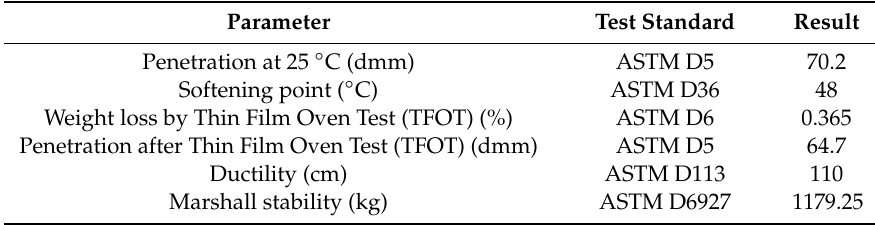
Table 1. Specifications for asphalt penetration grade (pen grade) 60 /